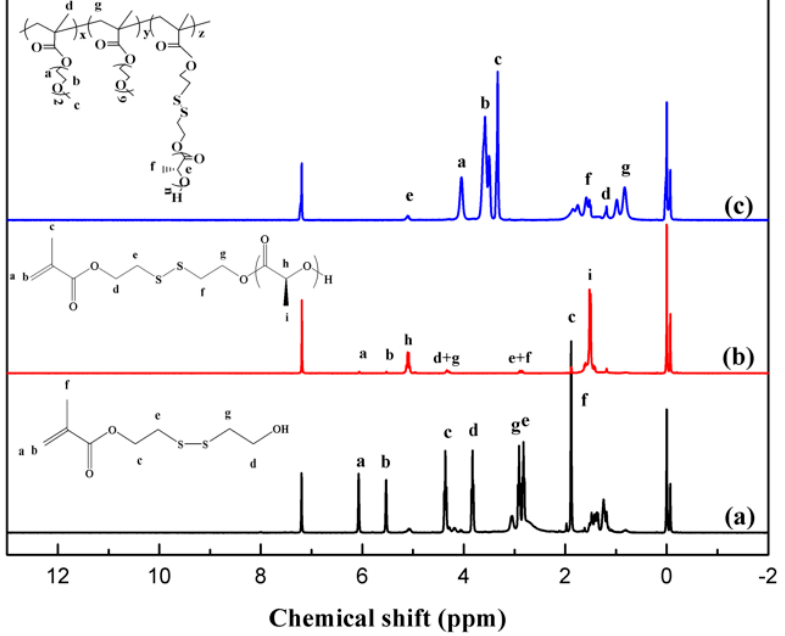
Figure 2. 1 H-NMR spectra of ( a ) initiator HSEMA; ( b ) macromonomer HSEMA-PDLA; ( c ) graft copolymer P(MEO 2 MA- co -OEGMA)- g -(HSEMA-PDLA).